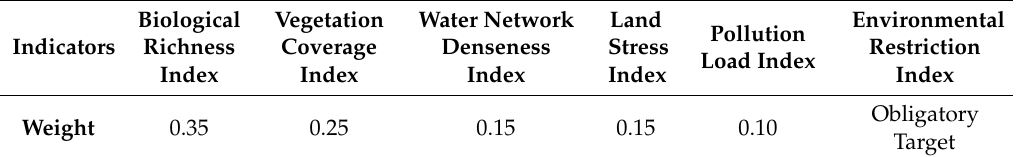
Table 3. The weight of